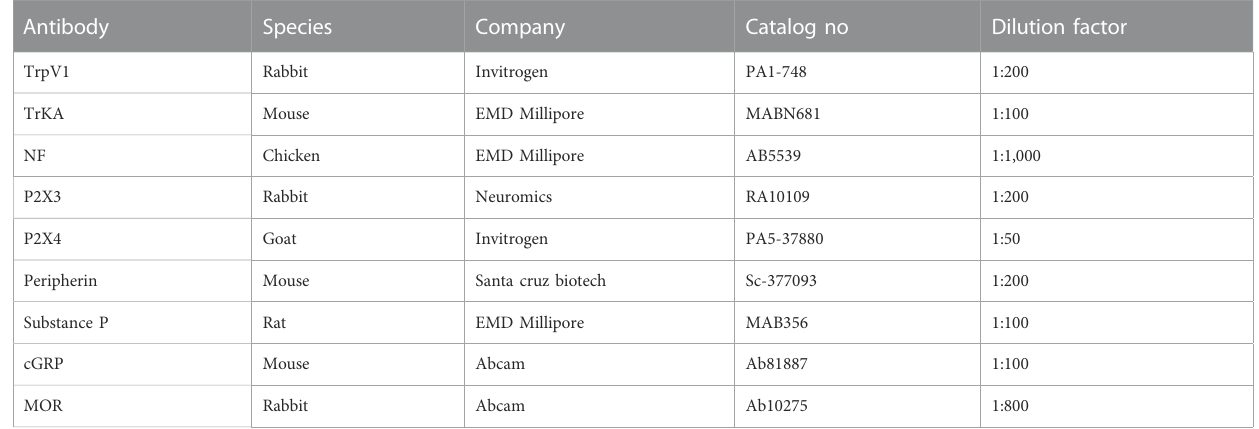
TABLE 1 The list of primary antibodies utilized in this study. Antibody